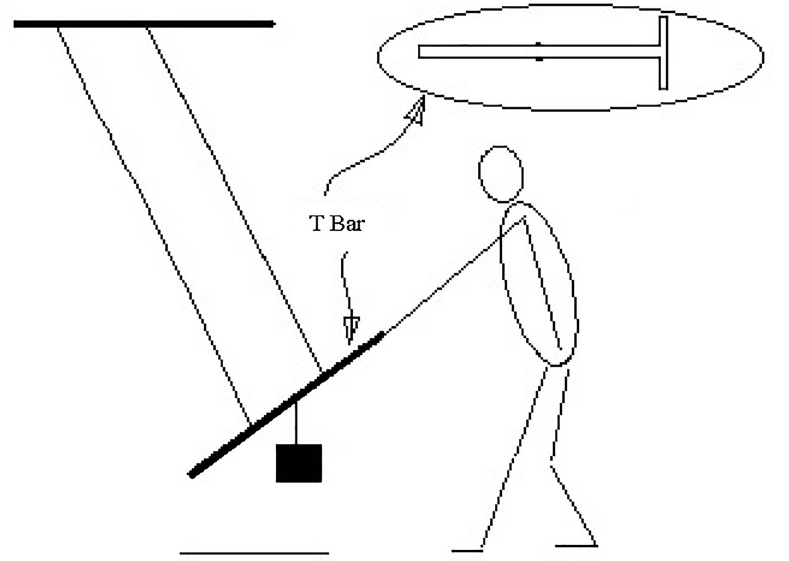
Fig 1. Suspended T bar and the simulated pulling task.